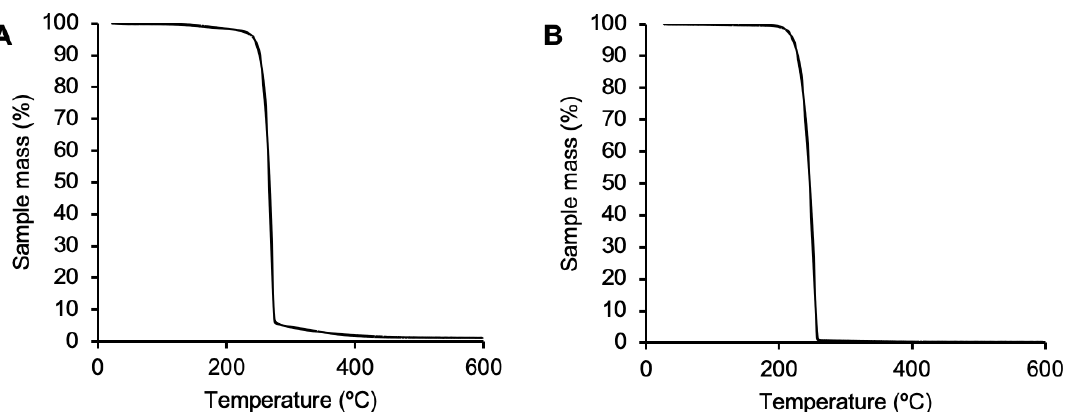
Figure 4. Thermal gravimetric analysis (TGA) of extracted PHA before ( A ) and after ( B ) purification with 1-butanol.